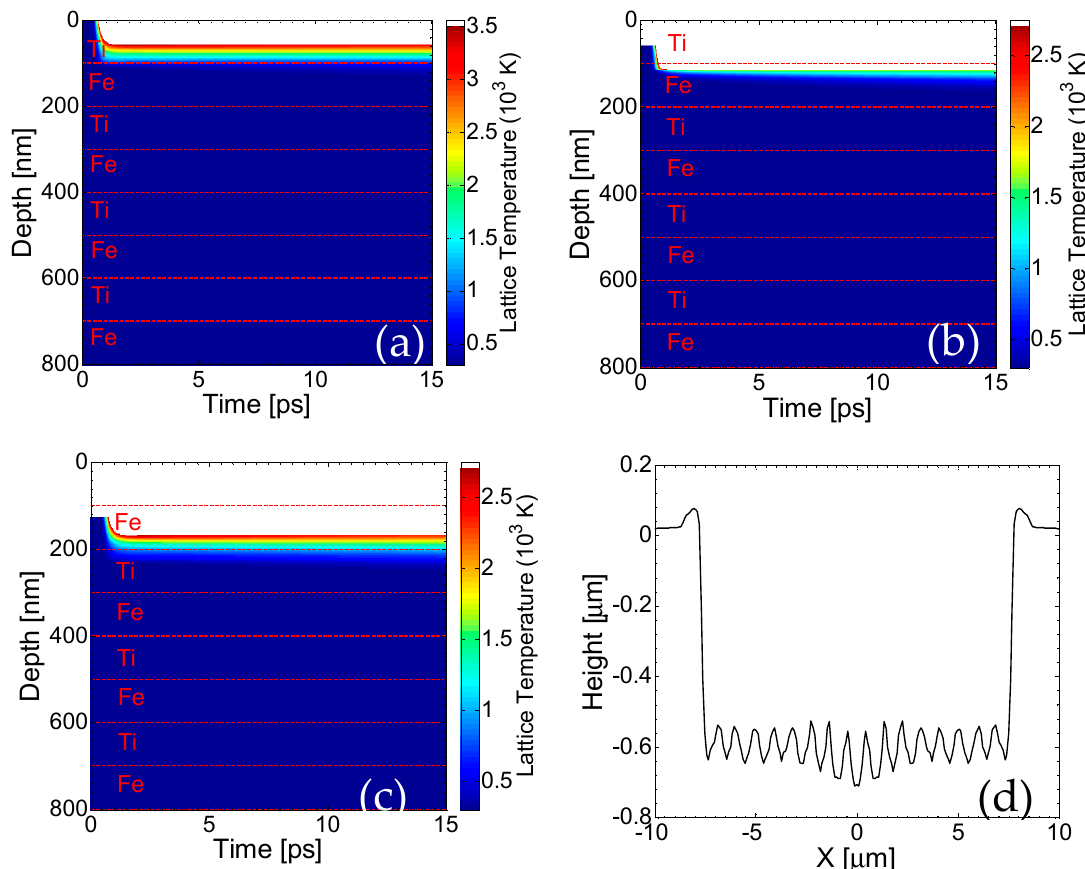
Figure 5. Lattice temperature field evolution in depth (in the center of the Gaussian spot) perpendicular to the surface of the sample after one pulse ( a ), two pulses ( b ) and three pulses ( c ) (white region indicates material removal, horizontal dashed line show the borders of the films); ( d ) periodic pattern after fourteen pulses (laser polarization is vertical to the figure plane).